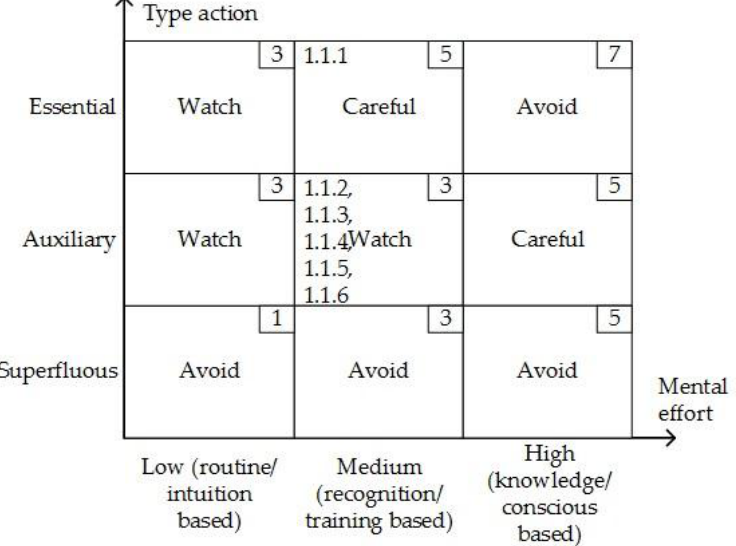
Figure 4. Critical importance matrix of actions in task analysis.